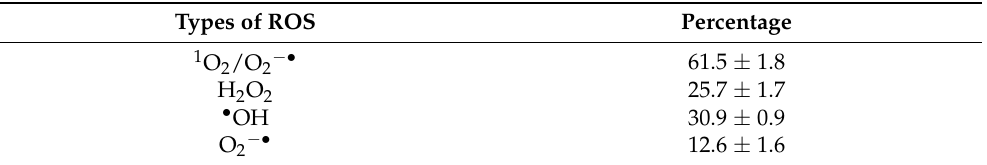
Figure 5. ( a ) ROS levels of MDA-MB-231 and HS27 cells were treated with different concentrations of N-GQDs/TiO 2 NCs (0.05–0.5 mg mL − 1 ) and were irradiated with NIR light for 20 min. Data are presented as the mean ± SD of two independent experiments made in three replicates ( n = 6) and normalized to control. Significant difference was tested using a two-way ANOVA followed by a Bonferroni post-hoc test and compared to MDA-MB-231, ** ( p < 0.01) and *** ( p < 0.001), ( b ) Comparison of photo-induced ROS generated by N-GQDs/TiO 2 NCs under irradiation of NIR light as a function of irradiation time and ( c ) A proposed possible mechanism of ROS generation by N-GQDs/TiO 2 NCs upon NIR light irradiation. Table 1. Proportion of different ROS (%) generated by N-GQDs/TiO 2 NCs (0.5 mg mL − 1 ) under irradiation of NIR light for 20 min.